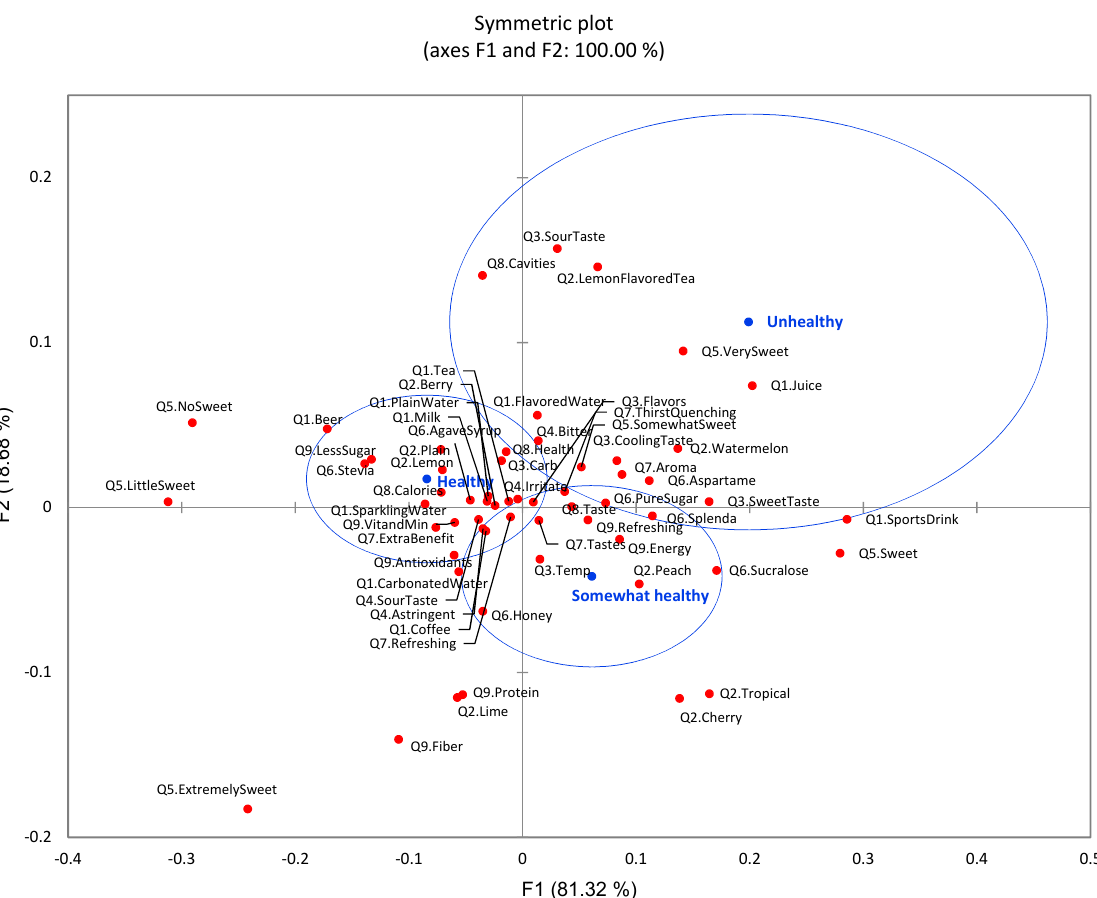
Figure 11. The first two dimensions of correspondence analysis (CA) symmetric plot using health condition (unhealthy, somewhat healthy, and healthy) as rows and all nine survey questions as columns ( n = 901) (3 rows × 58 columns). Confidence ellipses on the plot were automatically created by XLSTAT software based on CA with observed χ 2 = 208.26 and p < 0.0001.